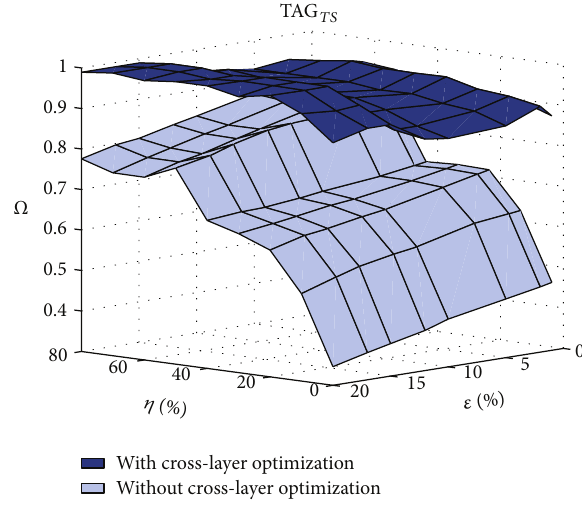
Figure 9: Ω for time-varying semantic tagging TAG 𝑇𝑆 .